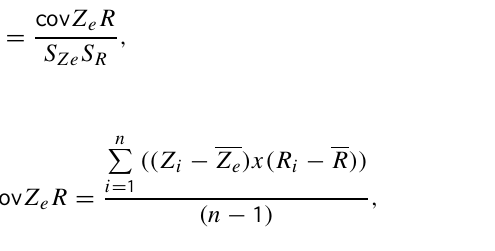
Fig. 5. The concept of the window correlation matching method